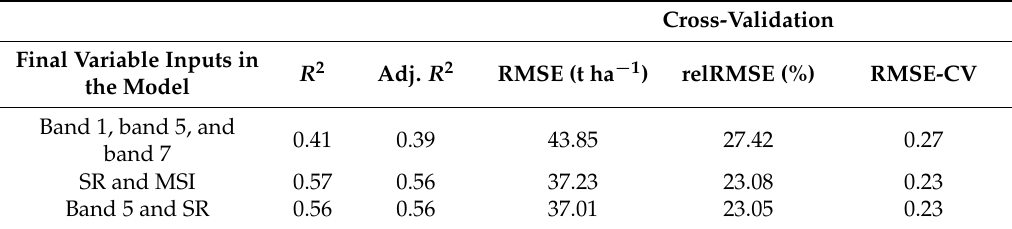
Table 4. Biomass prediction results based on the